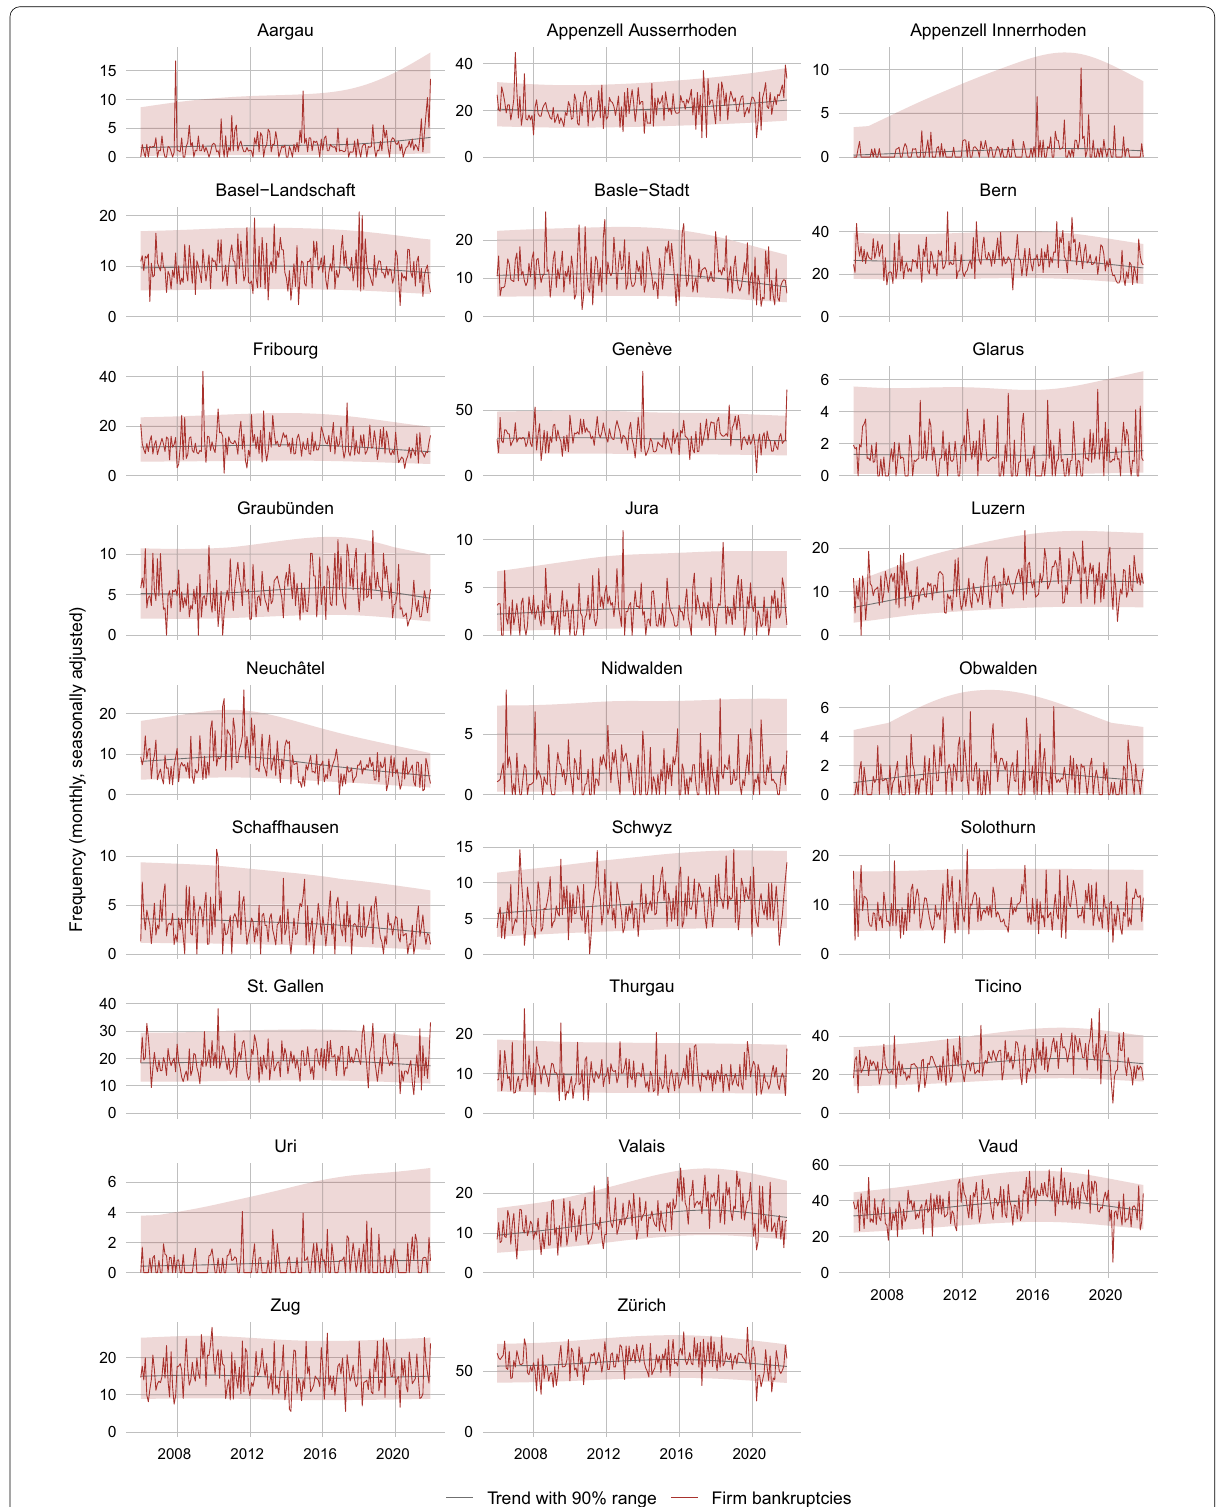
Fig. 18 Monthly frequency of firm bankruptcies at the cantonal level. Notes : The figure shows the monthly seasonally adjusted frequency of firm bankrupcties in the Swiss cantons excluding SCO Art. 731b cases, together with a trend and the 90% probability